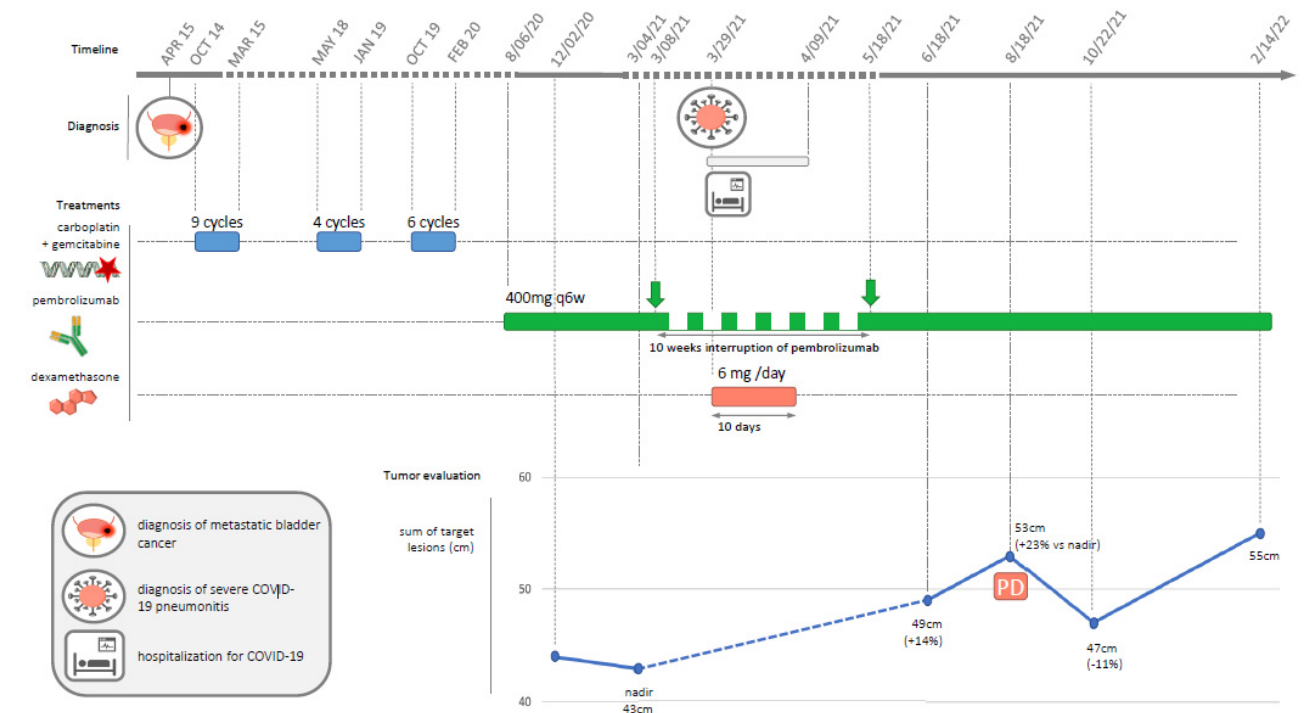
Figure 1. Timeline of patient history depicting cancer diagnosis, cancer treatments, and COVID-19 diagnosis and treatment. In April 2014, a 75-year-old man with a history of smoking (20 pack-years) presented with hematuria, which revealed an FGFR wild-type urothelial bladder carcinoma with lung metastases. The patient was also treated for hypertension and diabetes. He was treated with a